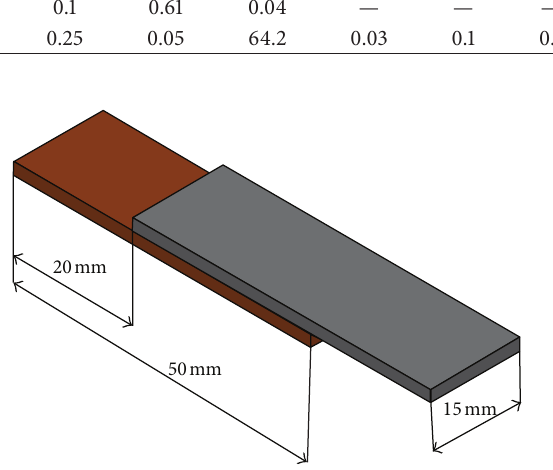
Figure 1: Dimensions of the prepared specimens for tensile shear